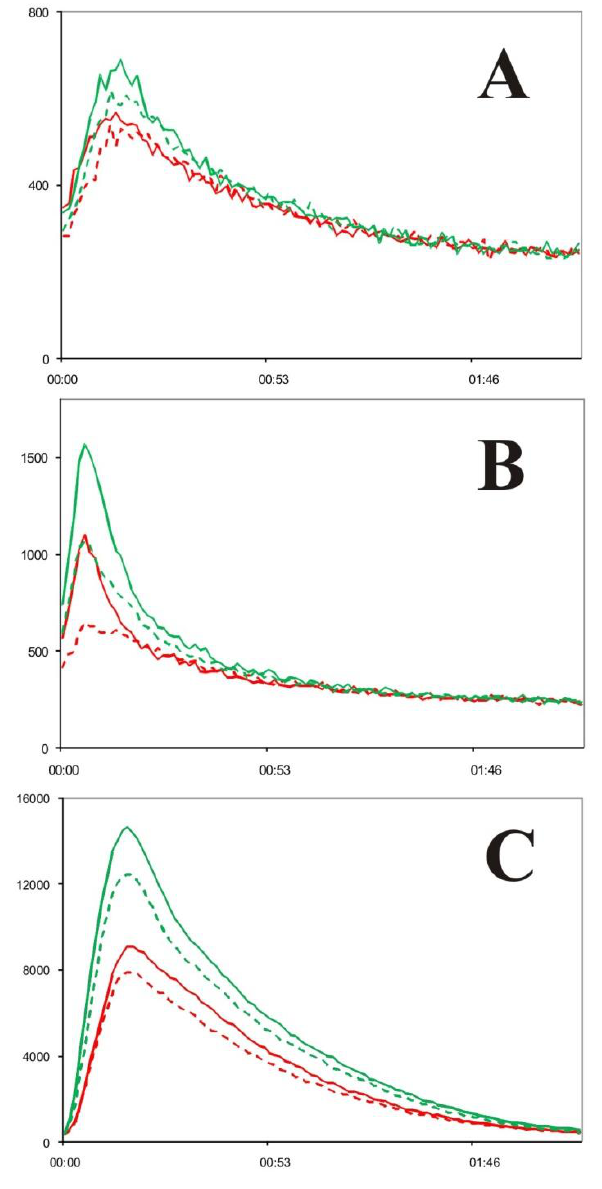
FIGURE 5. Preincubation with V vesicles sto enhances stimulus-dependent ROS generation of neutrophils. Neutrophils were preincubated with V vesicles (green lines) or buffer alone (red lines) sto for 30 min at 37°C. Cells were pelleted, washed three times in PBS to remove the vesicles, resuspended in luminol-containing buffer without (solid lines) or with (broken lines) SOD, left unstimulated (A) or stimulated with fMLP (B) or opsonized zymosan (C), and immediately assayed for ROS generation by luminometry as described in the Materials and Methods section. The luminometric output (y axis) is in arbitrary units and the time (x axis) in